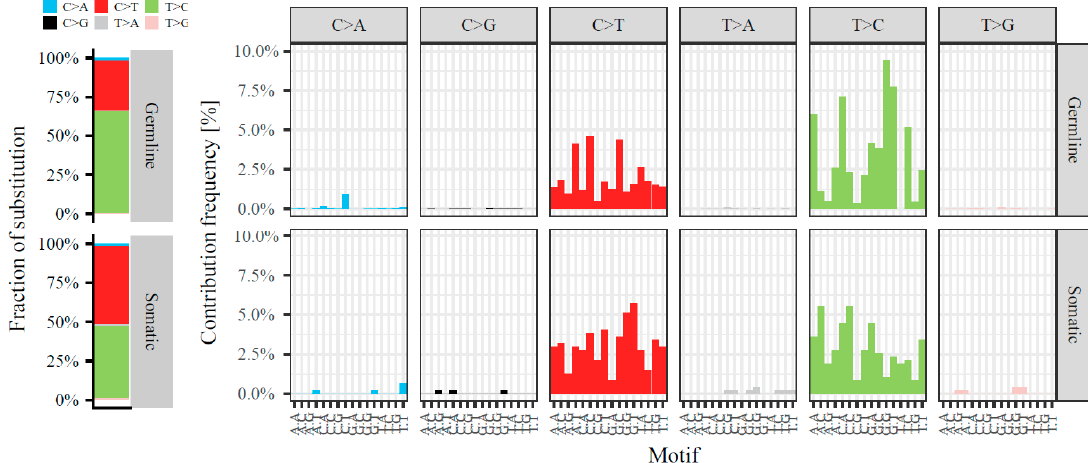
Figure 4. Somatic spectrum of mitochondrial RNA variants of 344 primary breast tumor cases. The contribution of the six possible base substitutions (C > A in blue, C > G in black, C > T in red, T > A in grey, T > C in green and T > G in pink) ( left ) and the context of each substitution (bases immediately 5 ′ and 3 ′ to each variant in the reference genome) ( right ) are depicted for the germline (top) and somatic (bottom) variants (left). Note that variants on position 2617 (known RNA-DNA differences) are not included.